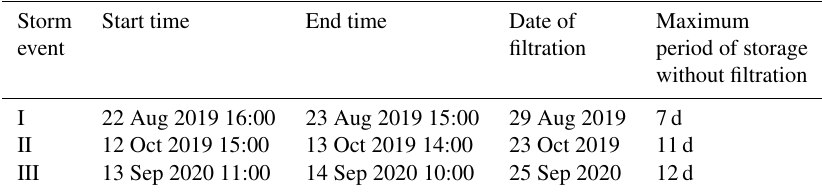
Table 1. Information on the samples taken during the intensive